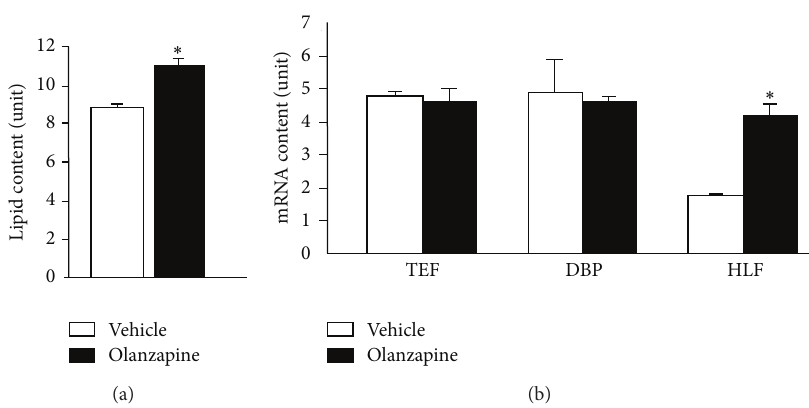
Figure 5: Effect of olanzapine on lipid content (a) and mRNA content of mammalian Pdp1 homologues (b) in mouse 3T3-L1 cells. Vehicle (open bars) and olanzapine (50 𝜇 M; closed bars) were present in the culture medium for 24h. Olanzapine increased lipid content (a) and HLF mRNA content (normalized to internal control mRNA) (b) ( ∗ 𝑃 < 0.001 versus corresponding control; 𝑛 = 6 ; mean ± standard error mean).